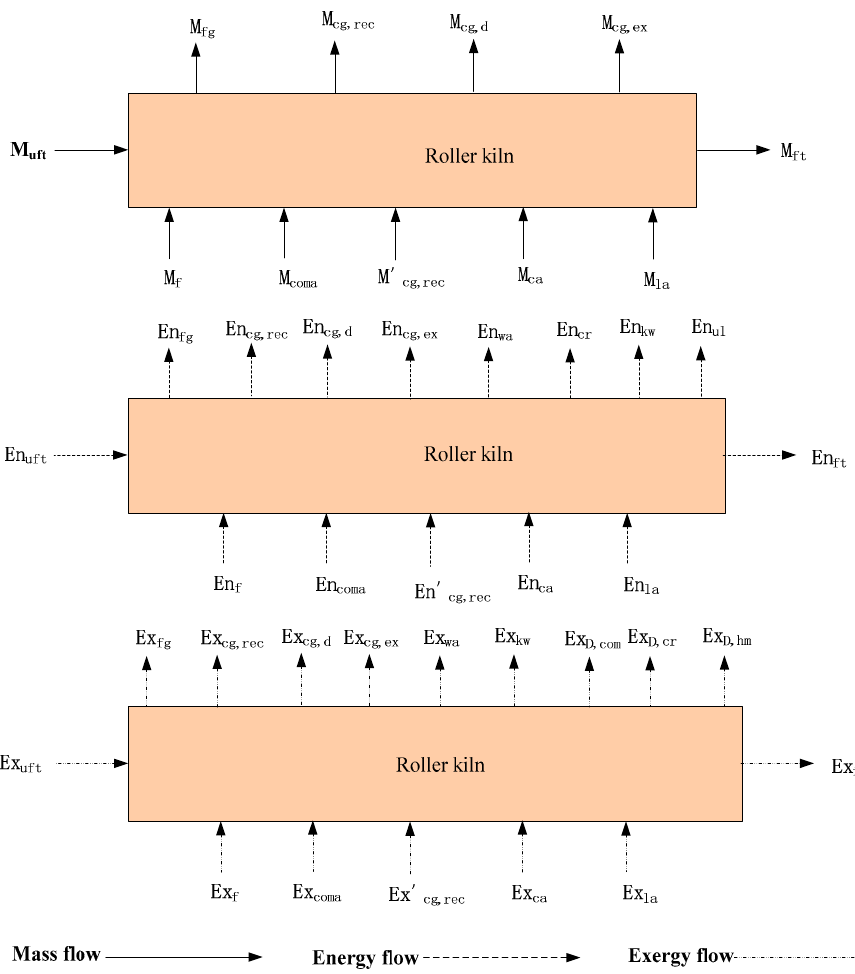
Figure 3. The mass, energy, and exergy flows of the roller kiln.